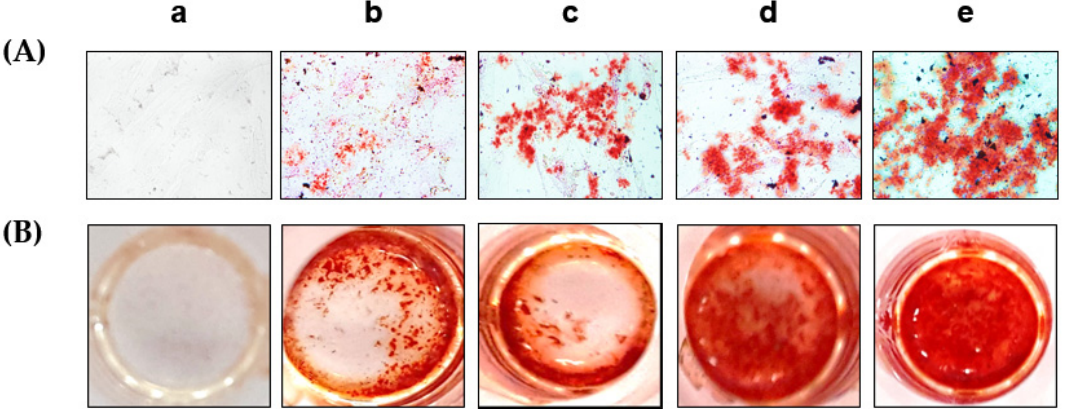
Figure 6. Induction of osteogenic differentiation of hMSCs. ( A ) von Kossa staining image of hMSCs after transfection with the indicated formulation. ( B ) Calcification of the cells detected by Alizarin Red S staining. The assays were carried out two weeks after the transfection. a. untreated; b. CaP/pBMP-2+mir148b;